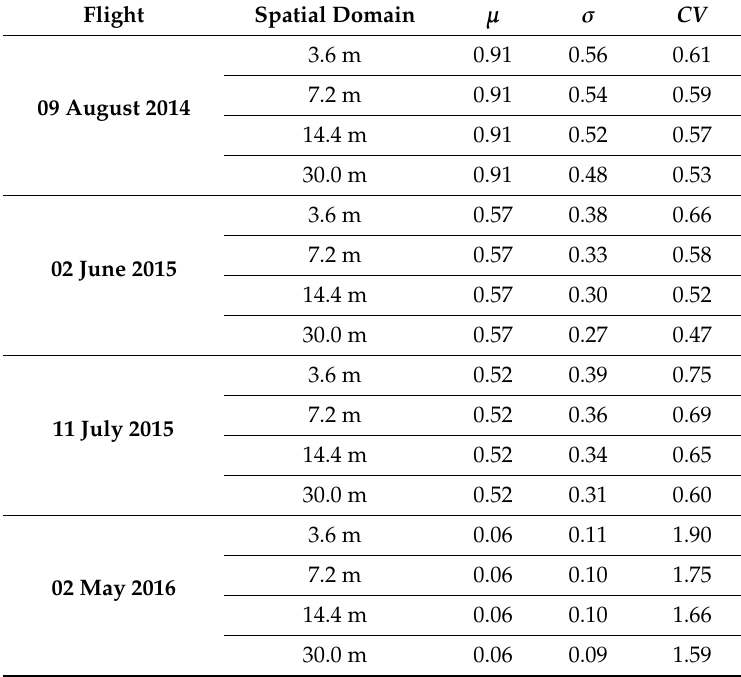
Figure 9. Example of modeled LAI (unitless) across different spatial domains for 09 August 2014. Table 4. Spatial domain effect on LAI estimation .